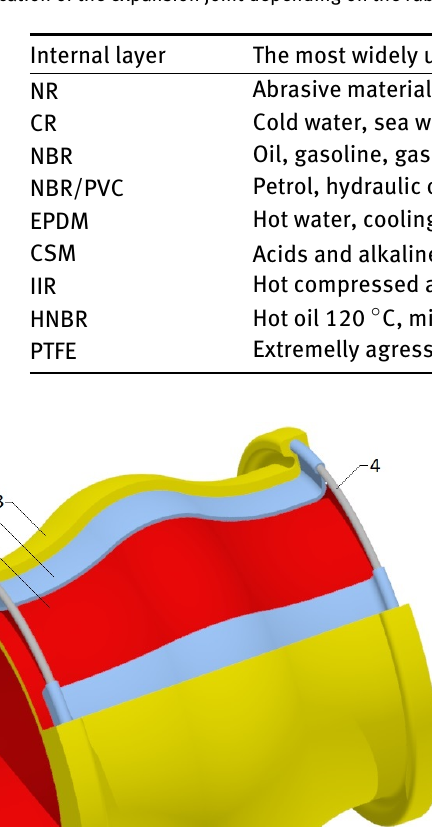
Table 1: Application of the expansion joint depending on the rubber.